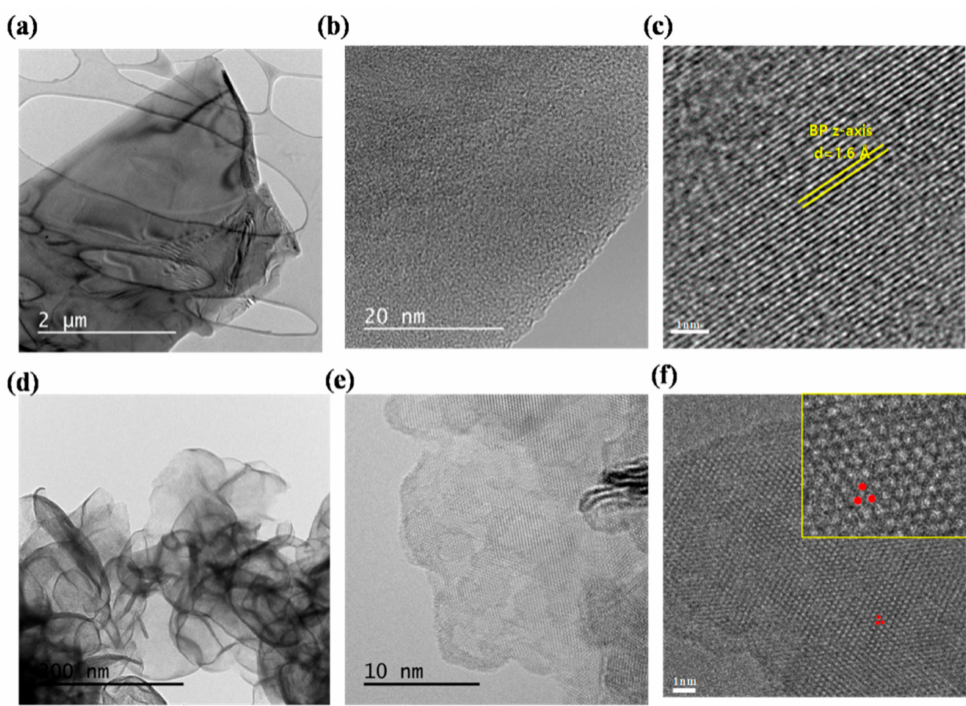
Figure 2. Typical low- and high-magnification high-resolution TEM image of ( a – c ) OBP ( d – f ) synthe- sized 1T-WS 2